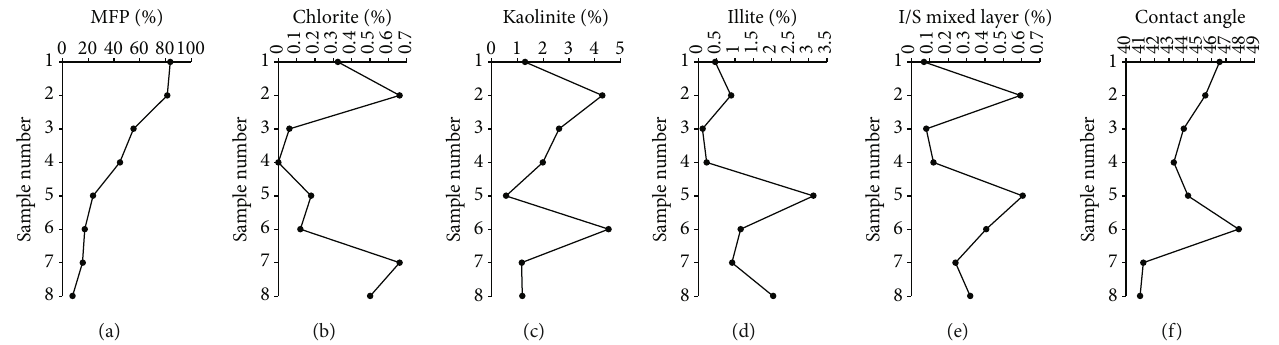
Figure 7: NMR, XRD, and wetting tests showing the variations of di ff erent samples.